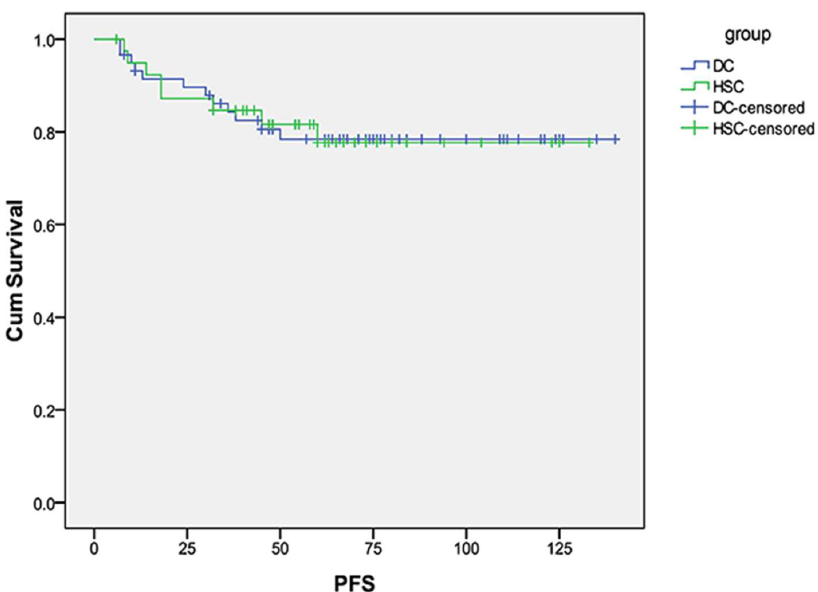
Fig 4. Progression free survival curves in patients with type II endometrial cancer for stage I and II diagnosed by HSC and D&C.